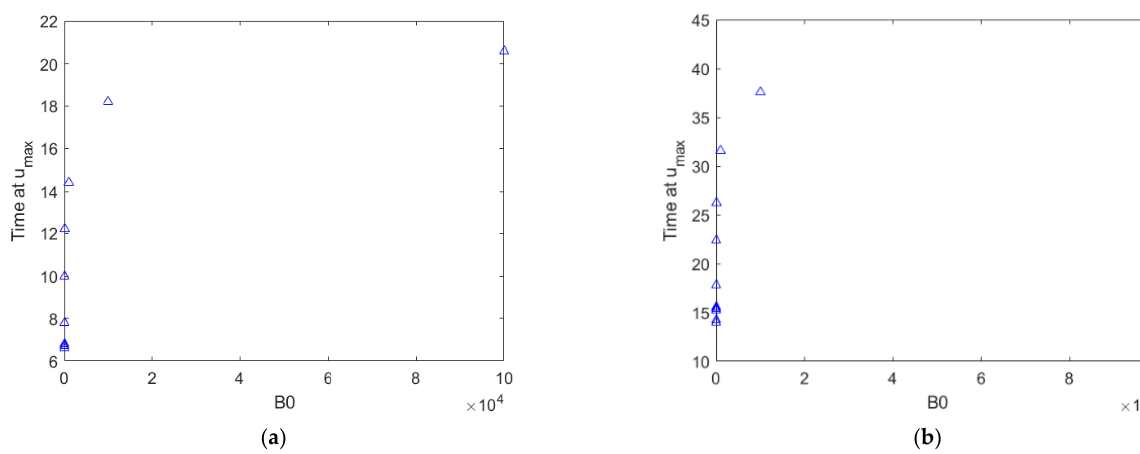
Figure 7. The max t time of Policy 1 against the changes in 0 B of Equation (15), against the fitted model of Equation (16). t time against the parameters For Policy 2, the plot of the max Figure 8. The plot again suggests a similar nonlinear logarithmic relationship to Equation t with respect to the changes in (16) for the function of max and